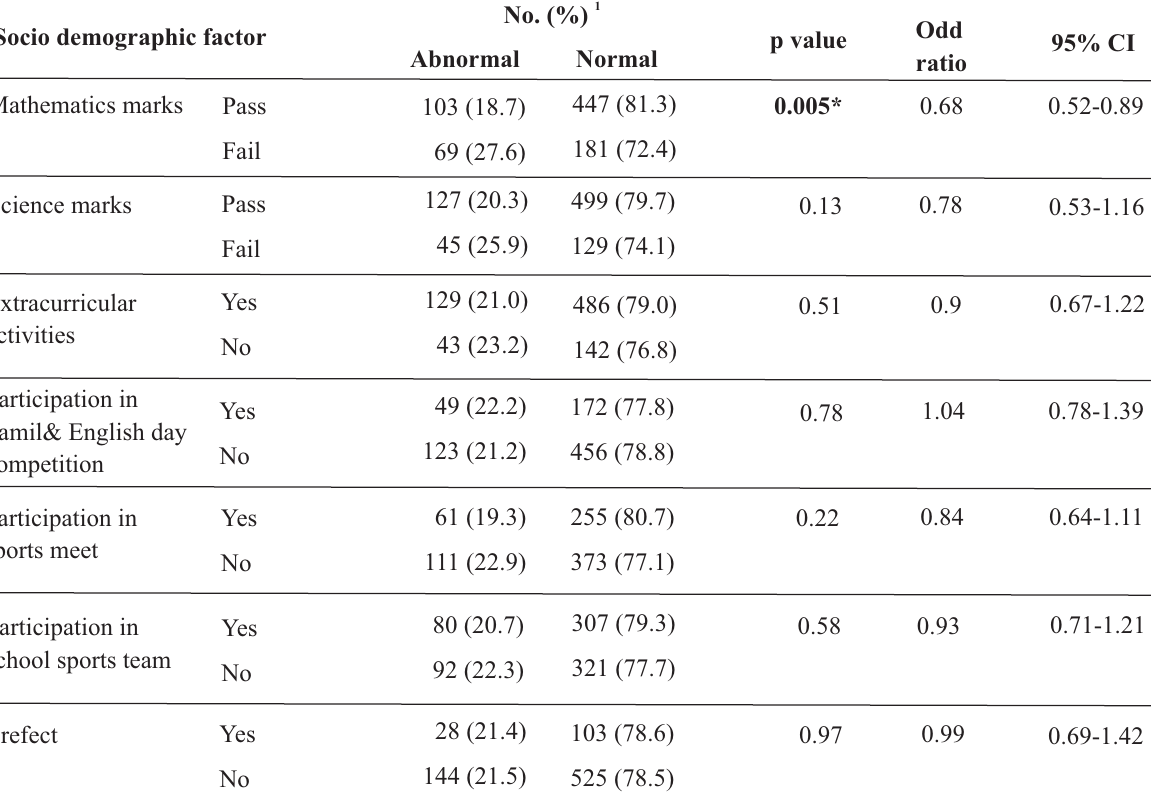
Table 4: Relationship between mental health status and student performance Socio demographic factor